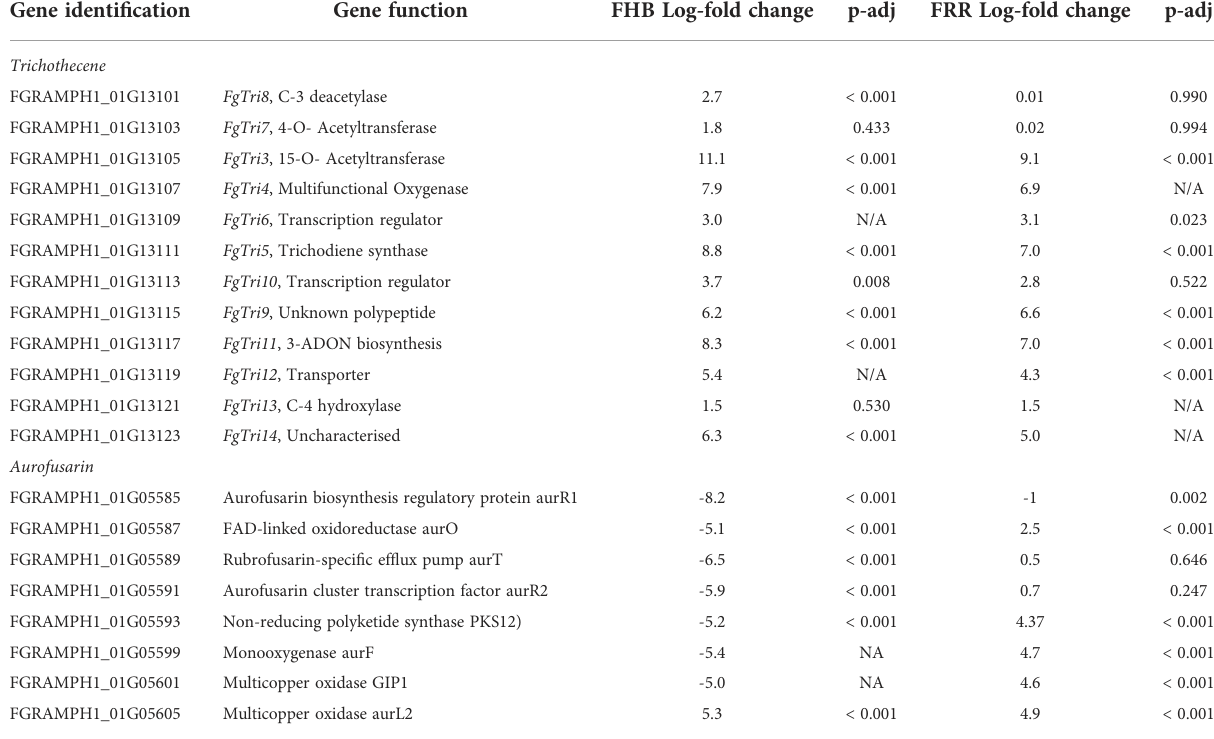
TABLE 1 Notable F. graminearum secondary metabolite clusters that were signi fi cantly expressed in FHB and